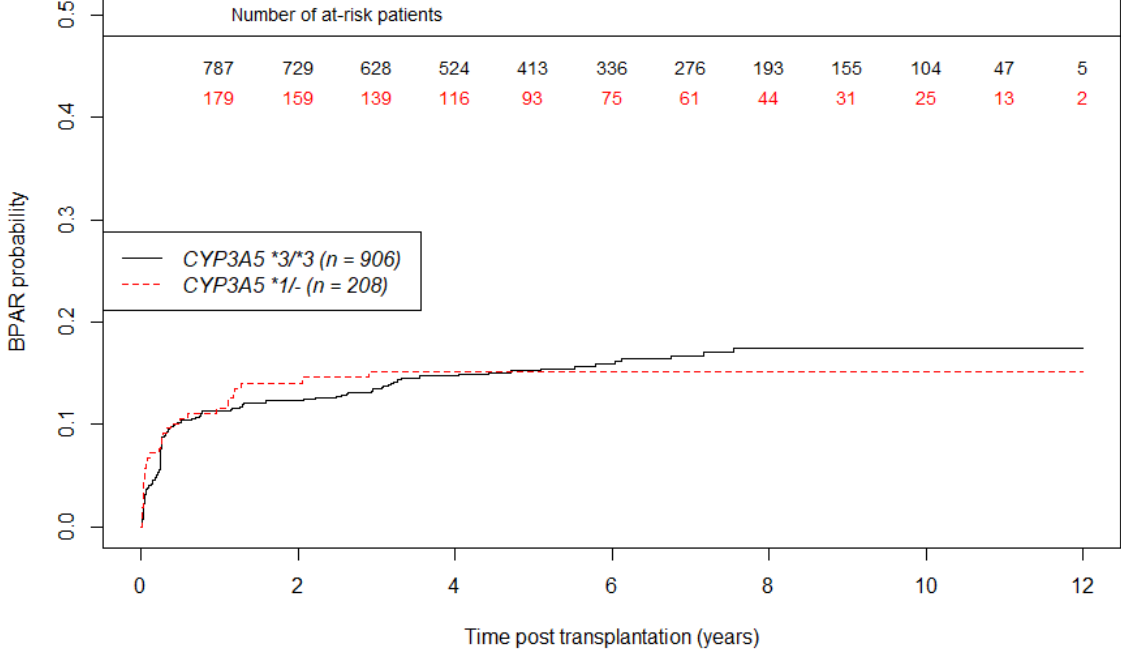
Figure 5. Unadjusted curves of biopsy proven acute rejection incidence using the Kaplan Meier estimator according to CYP3A5 genotype. (n = 1114 patients). Table 4. Multivariate Cox model for biopsy proven acute rejection.